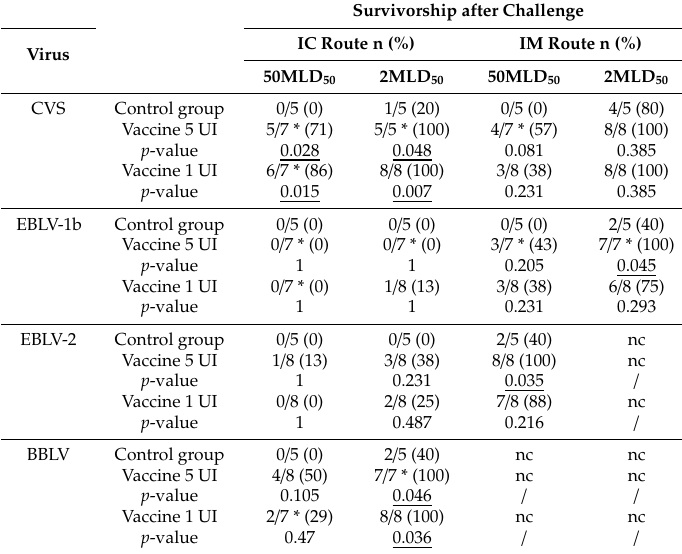
Table 1. Cross protection of rabies inactivated veterinary vaccine in mice challenged with 4 di ff erent rabies virus species by central / peripheral route at two di ff erent dosages. Survivorship after